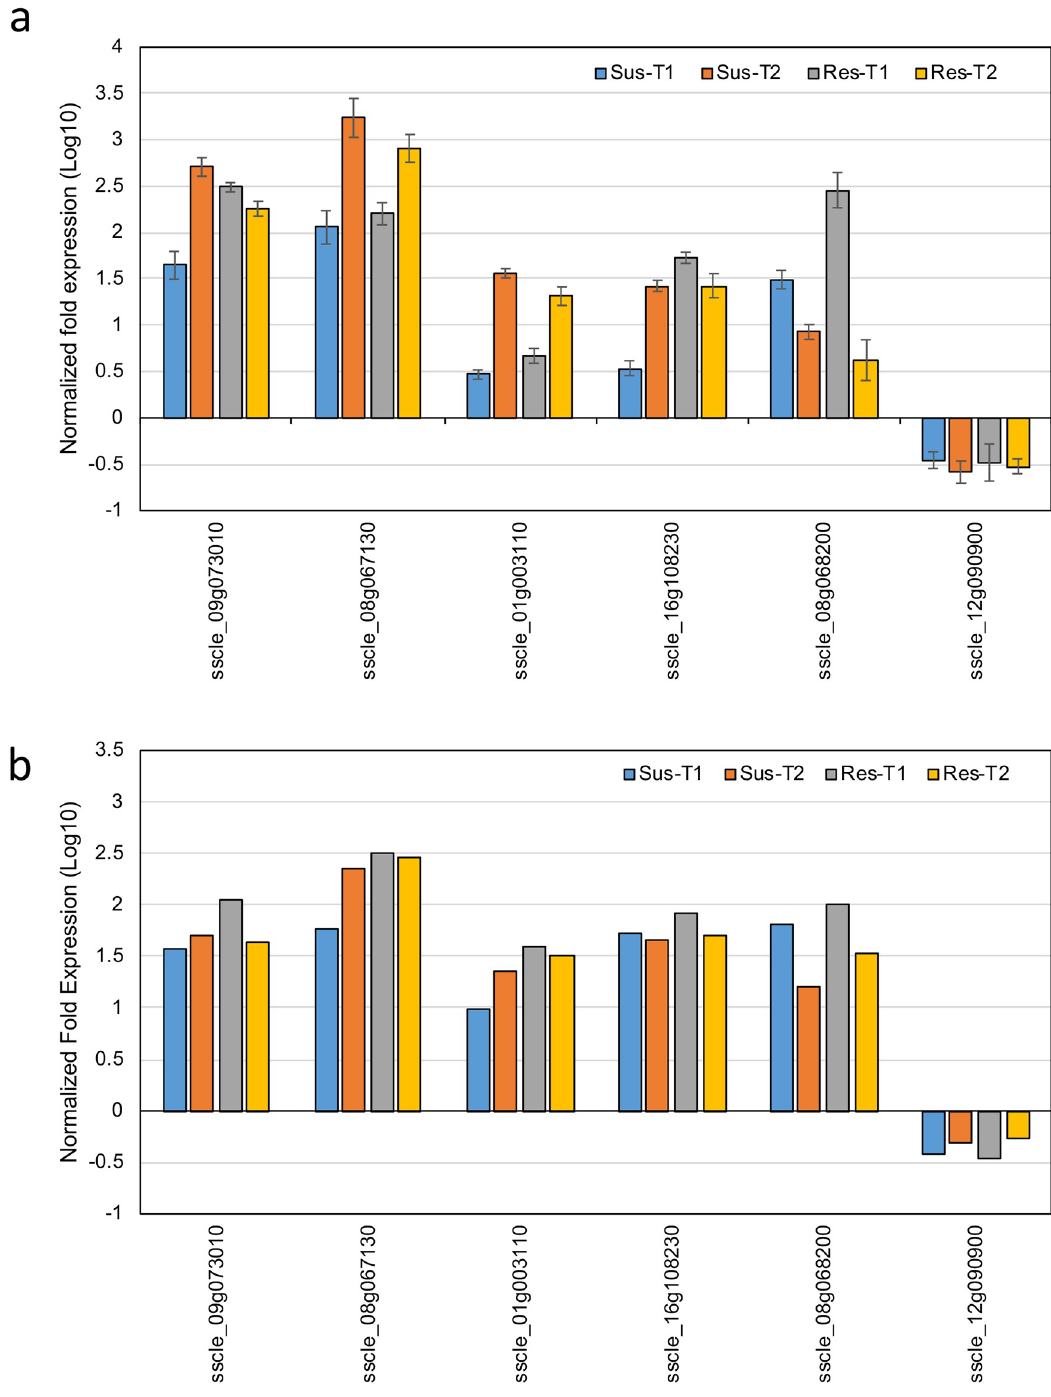
Fig 5. qRT-PCR validation of the relative expression levels of selected S . sclerotiorum differentially expressed genes. Expression profiles of six S . sclerotiorum genes as determined by a. qRT-PCR and b. RNA-Seq.